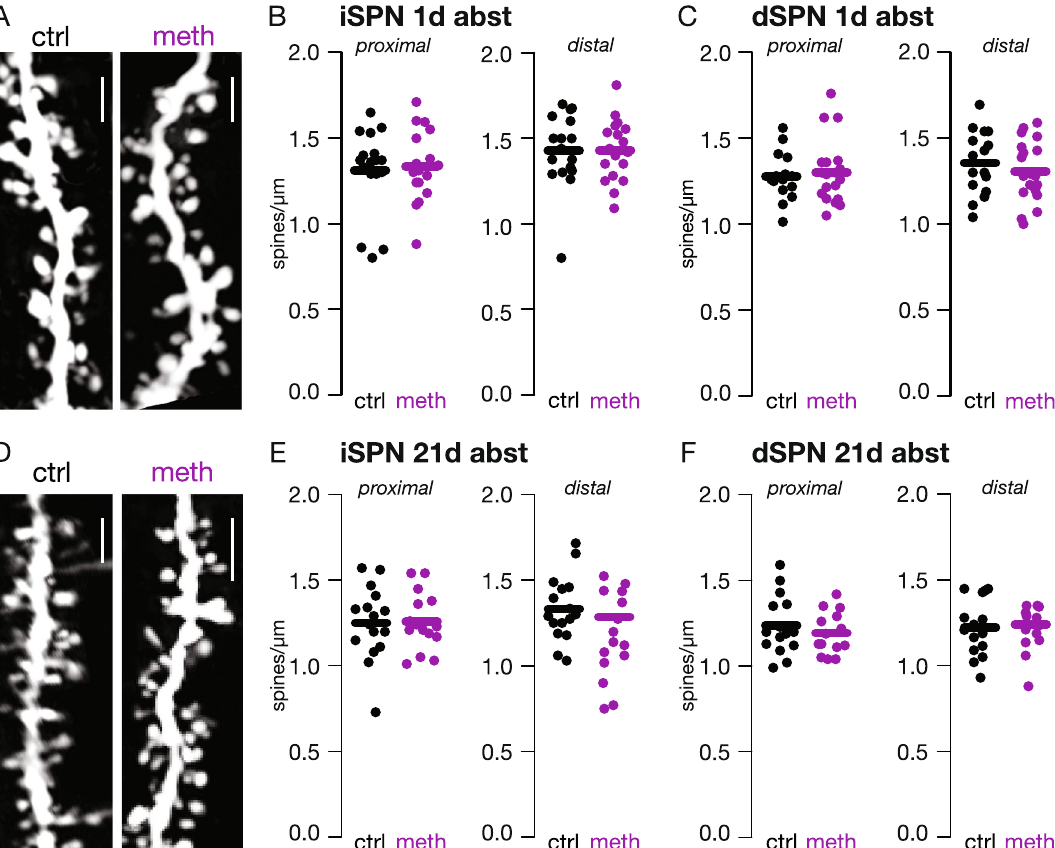
Figure 2. Repeated meth administration had no effect on DMS iSPN or dSPN spine density. ( A ) Sample images of DMS dSPN proximal dendrites from control (ctrl) and meth treated mice after 1 day of abstinence; scale bar denotes 10 µm. ( B ) DMS iSPN spine density was unchanged when measured during acute (1 day) abstinence from repeated meth (ctrl n = 16 neurons/6 mice; meth n = 19 neurons/7 mice). Data analyzed using unpaired t - or Mann–Whitney test as appropriate (proximal U = 119, p = 0.5737, two-tailed; distal: t (31) = 0.2832, p = 0.7789, two-tailed). ( C ) dSPN spine density was unchanged at acute (1 day) abstinence from repeated meth (ctrl n = 17 neurons/7 mice; meth n = 19 neurons/8 mice). Data analyzed using unpaired t - or Mann–Whitney as appropriate (proximal U = 239.5, p = 0.7824, two-tailed; distal t (34) = 0.6589, p = 0.5144, two-tailed). ( D